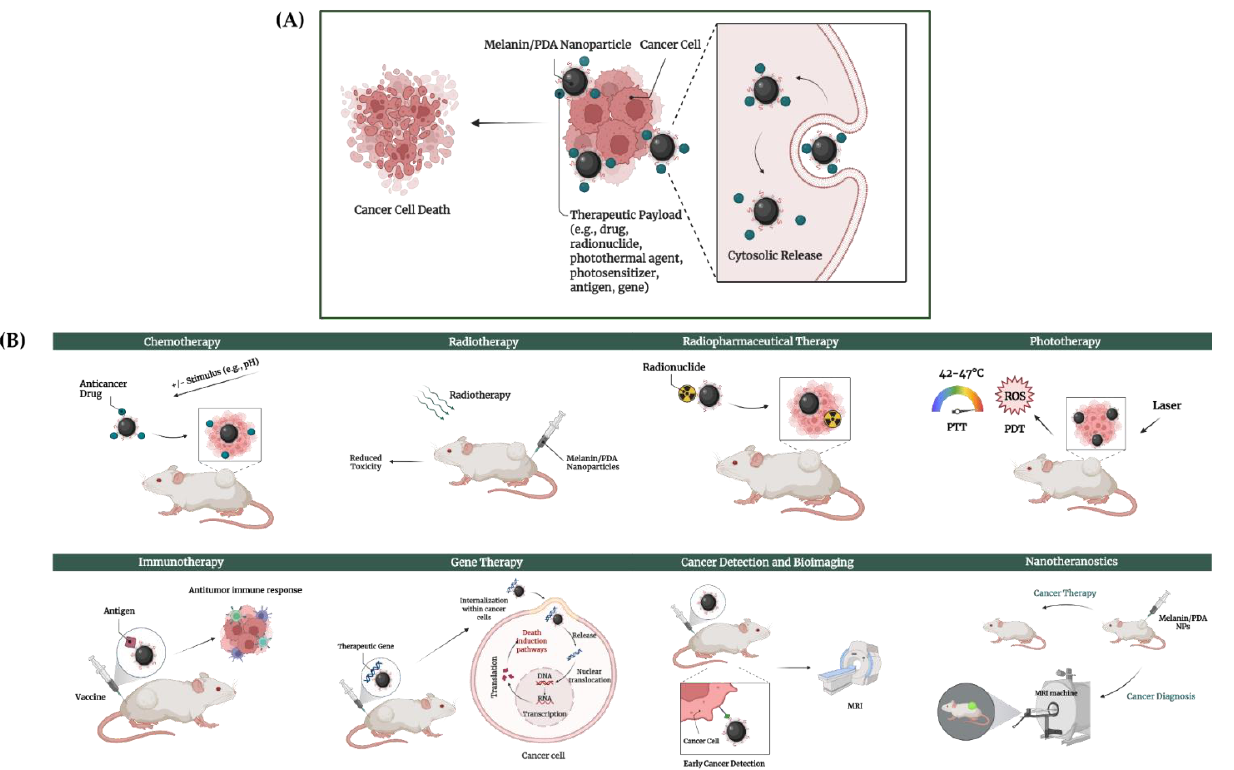
Figure 5. ( A ) Targeted delivery of therapeutics to cancer cells by melanin/PDA nanoparticles, and ( B ) main applications of melanin/PDA nanoparticles in cancer therapy. This image was created us- ing BioRender.com.